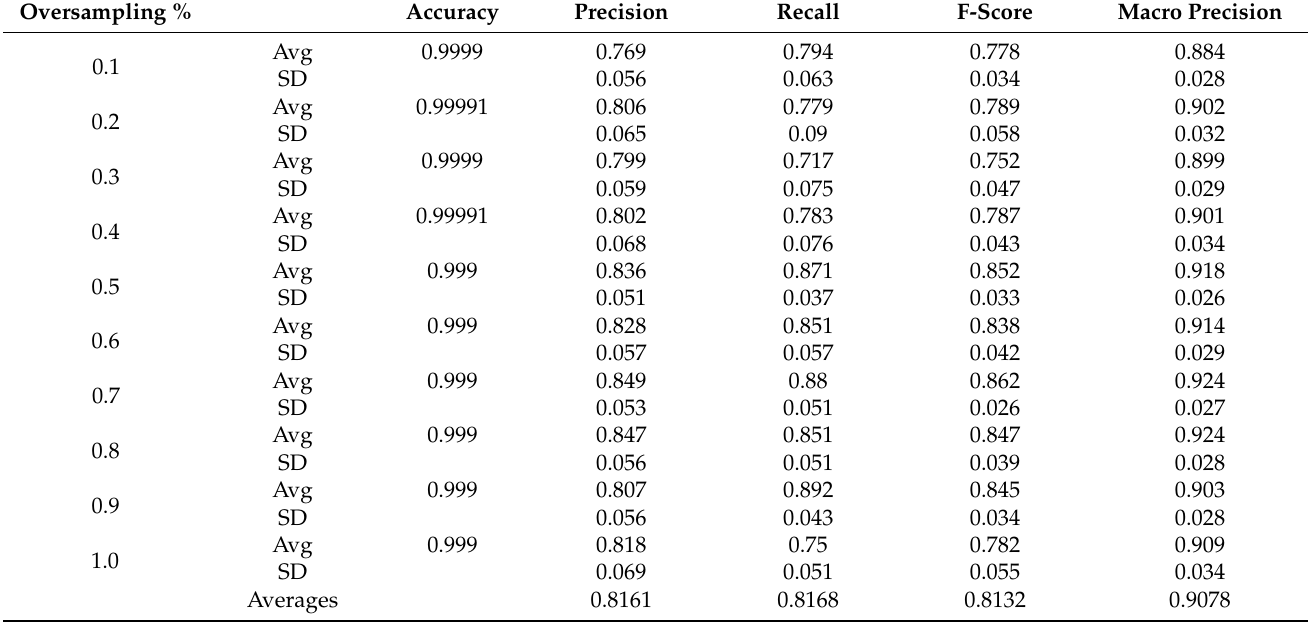
Table 5. UNSW-NB15: Worms—classification results for random undersampling before splitting.